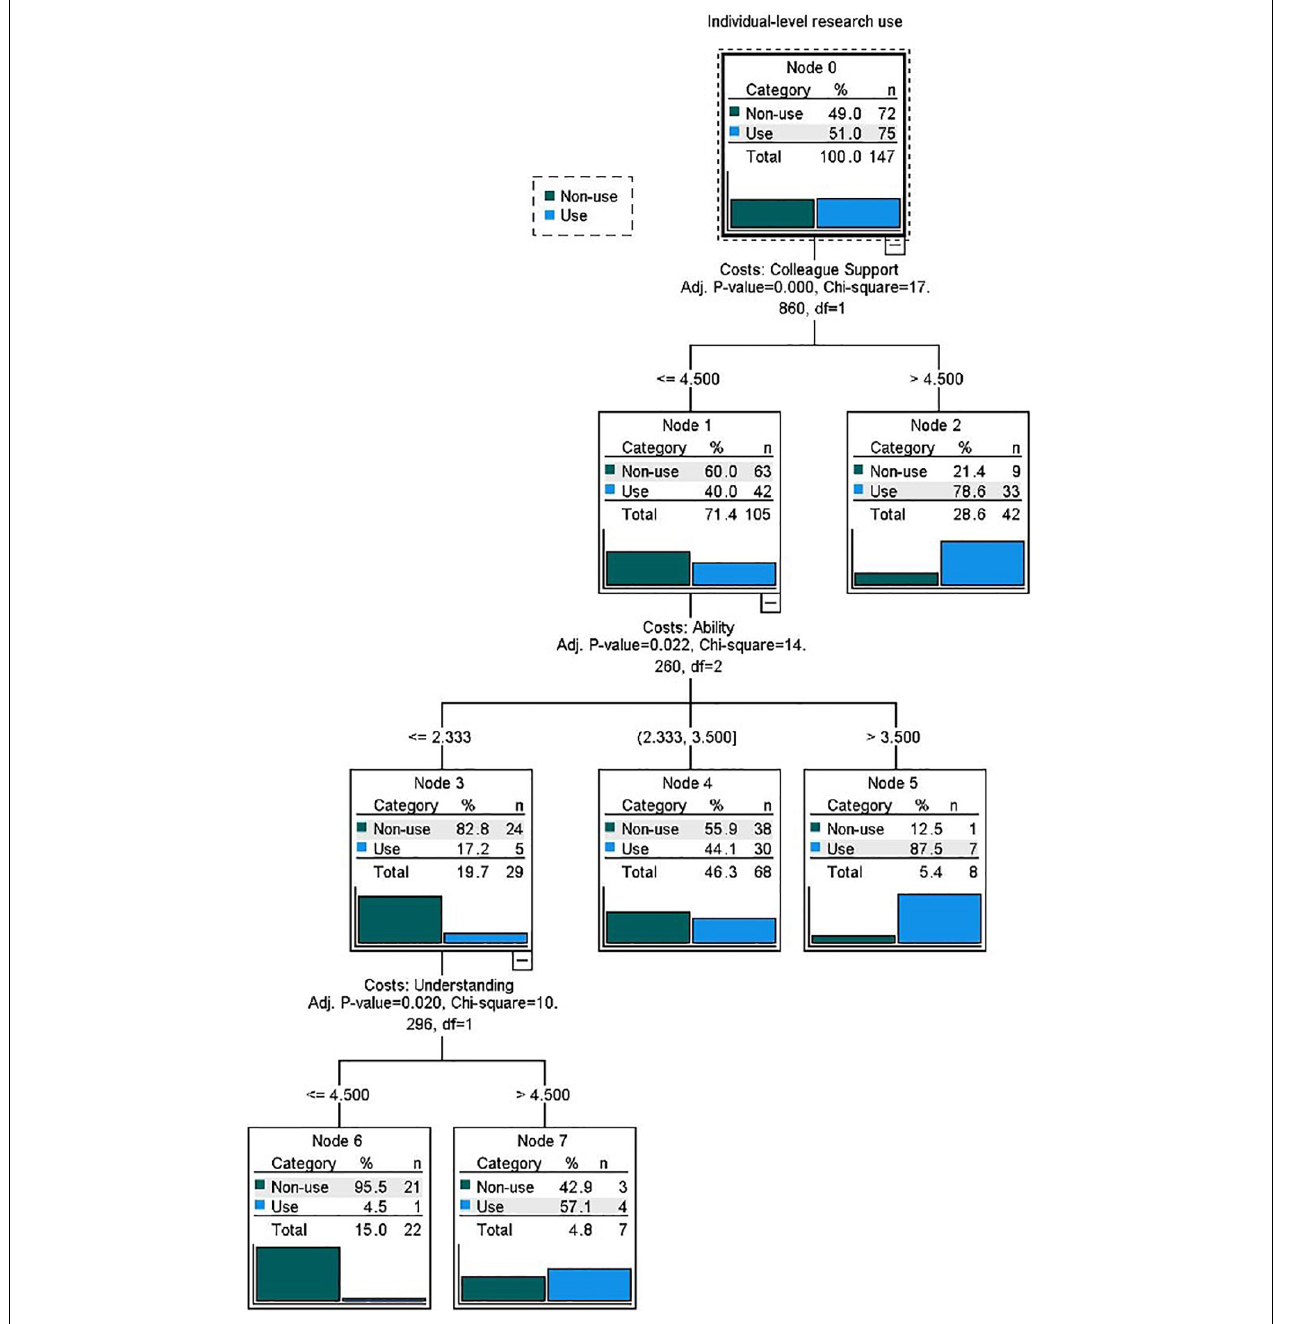
FIGURE 2 | Decision classification tree for the costs of research-use factors. Light gray shading within terminal nodes denotes the final